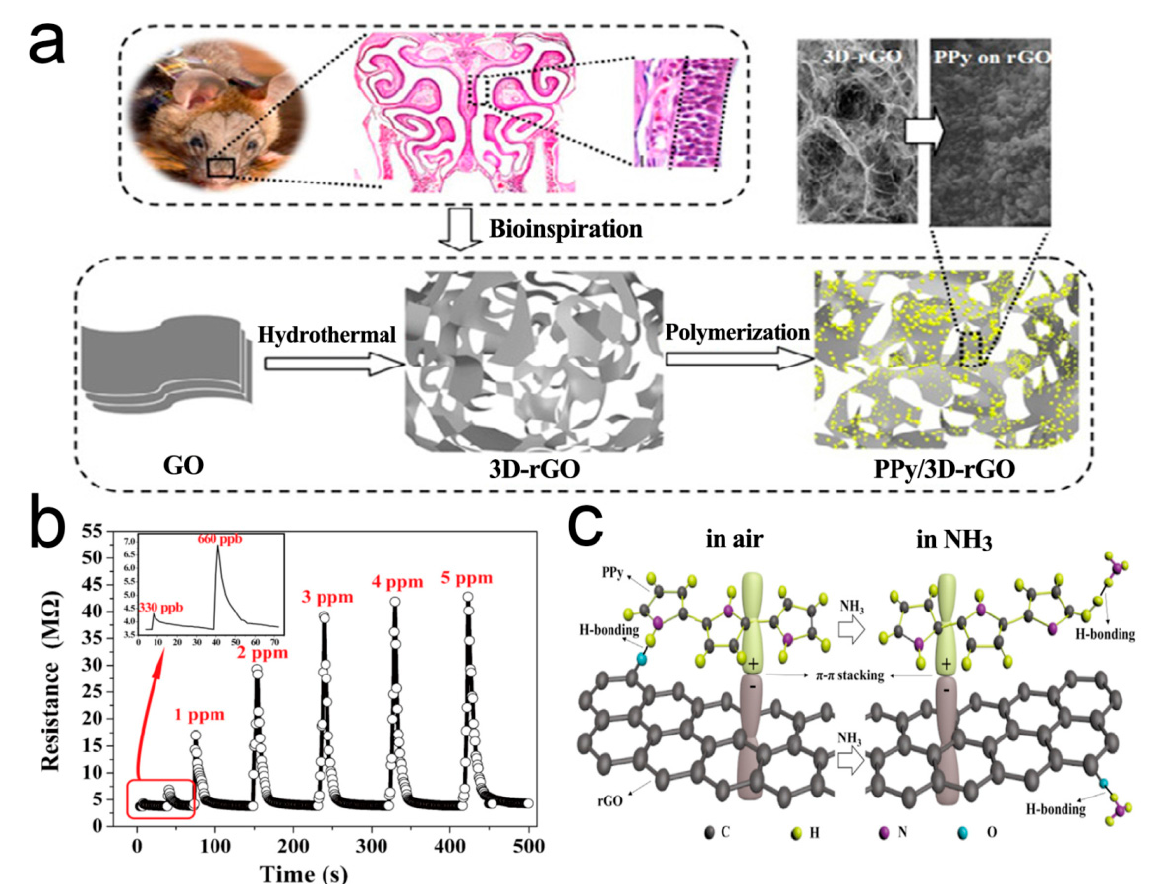
Figure 8. ( a ) Fabrication process for the 3D crumpled PPy/3D-rGO nanocomposite; ( b ) Dynamic response of the PPy/3D- RGO sensor to NH 3; ( c ) Schematic illustration depicting the interaction of NH 3 with PPy/3D-RGO [129].